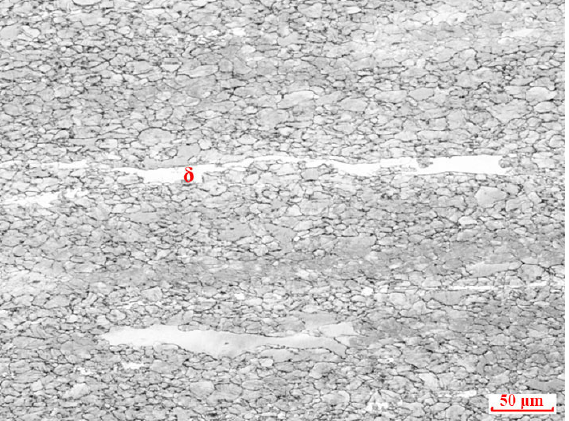
Figure 8. Optical microscopy of steel 1# under solid solution treatment at the temperature of 650 °C.